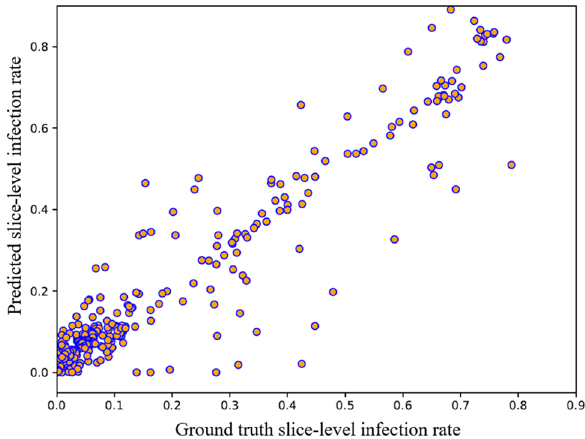
Figure 12. Ground truth and predicted slice-level infection rate in generalization assessment